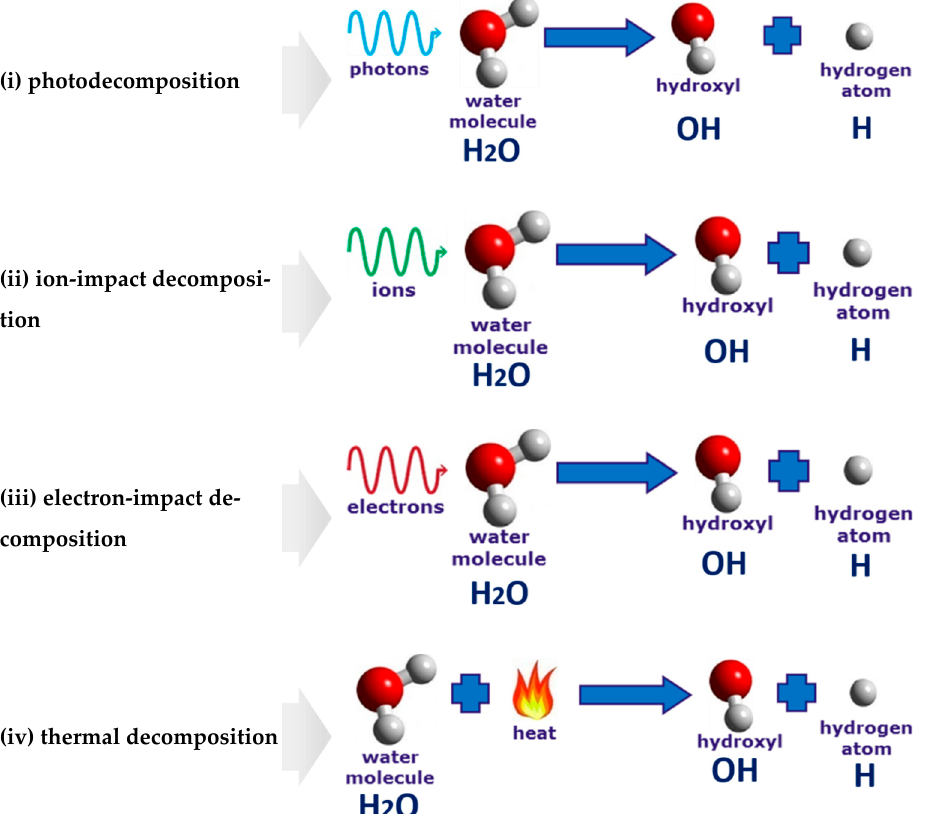
Figure 7. Illustration of the four processes leading to the water decomposition in the vicinity of the discharge